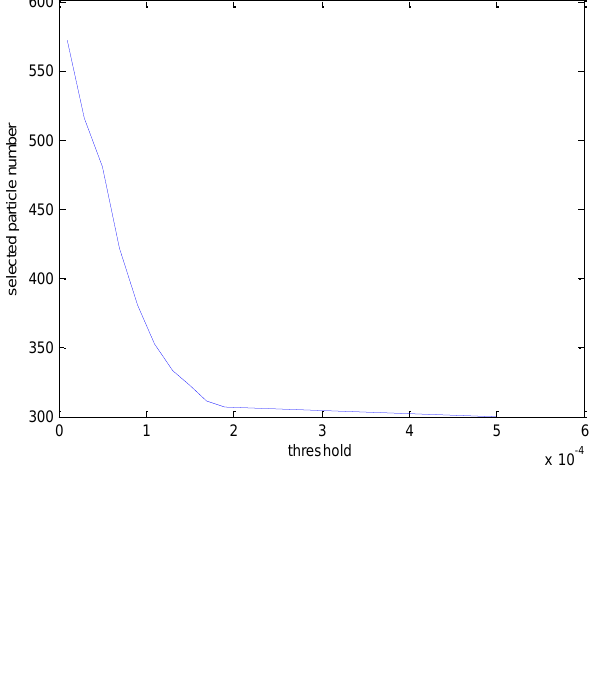
Figure 4. Selected particle number after performing QMRPF-UKF with different